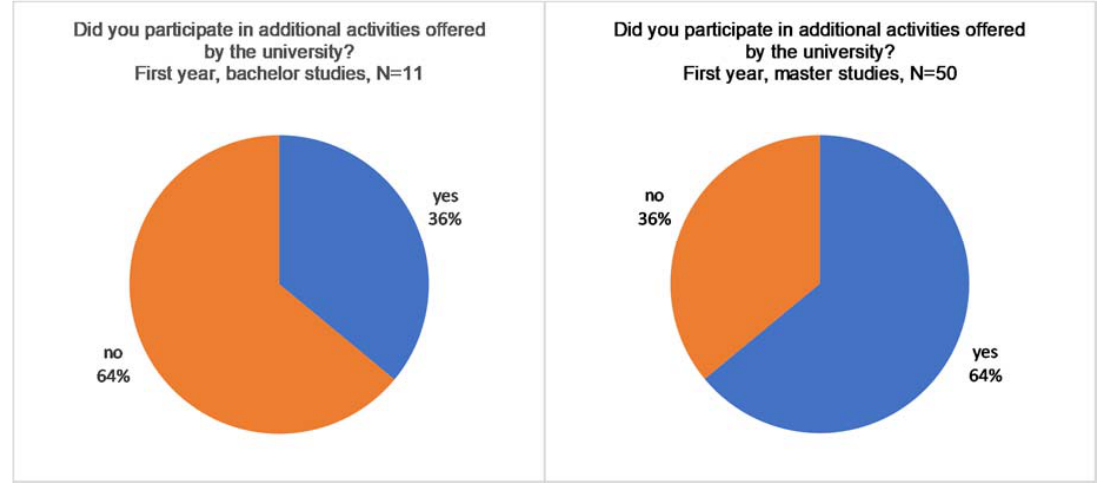
Figure 2. Students’ participation in extracurricular activities offered by the university.